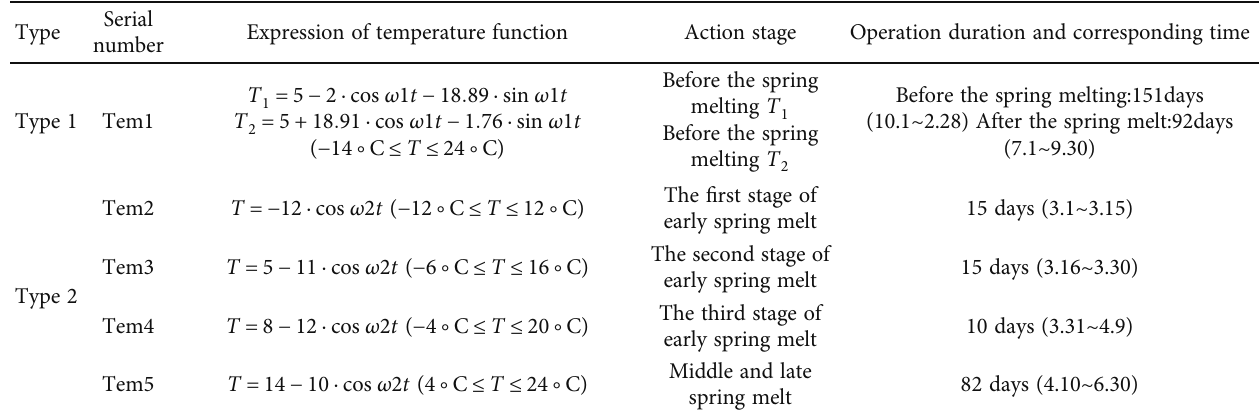
Table 5: Temperature function.